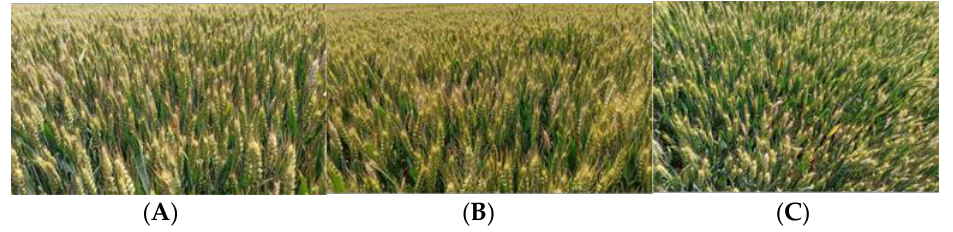
Figure 2. White spikes in the field in Linzhang. ( A ), No dressing (control); ( B ), dressing by Cruiser Plus; ( C ), dressing by Celest.